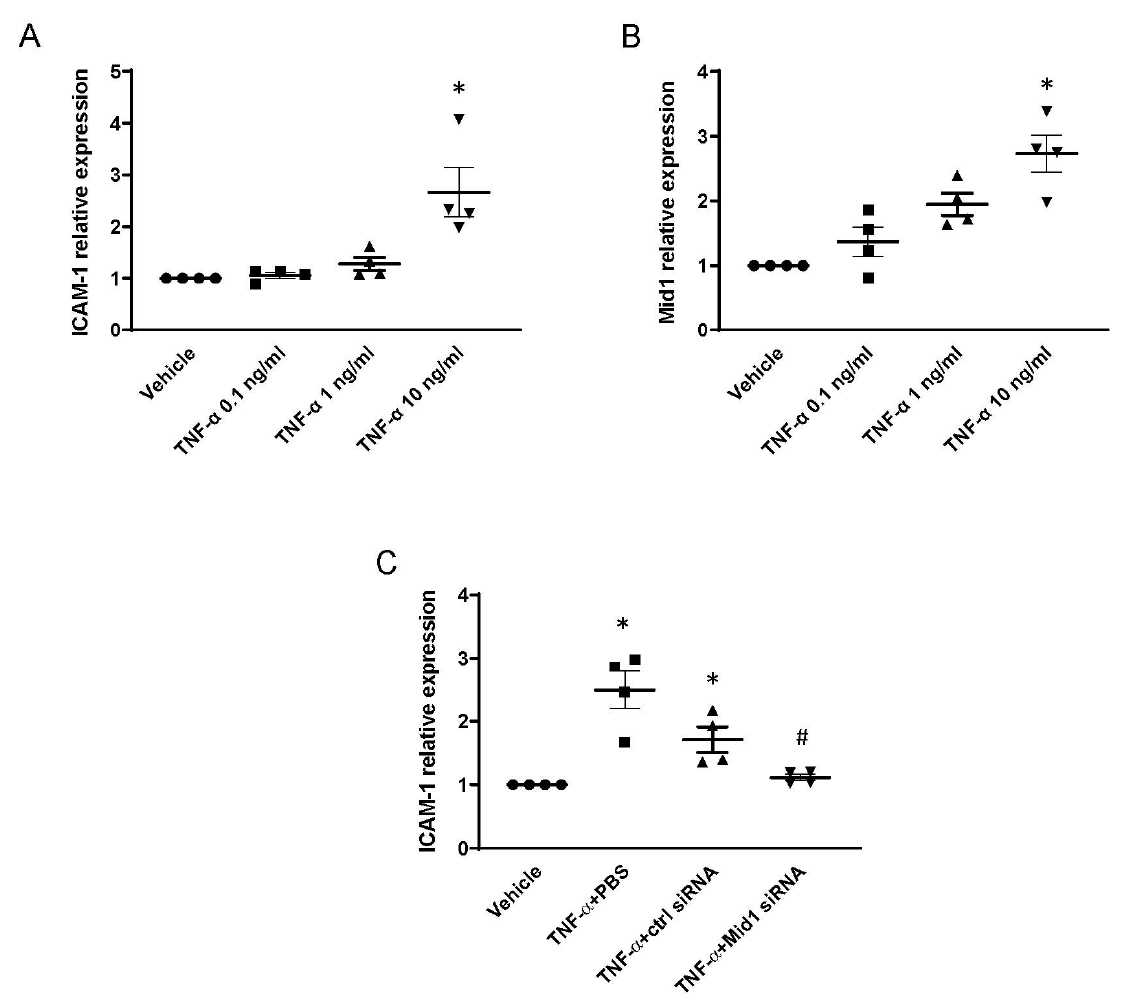
Figure 6. TNF- α increased ICAM-1 expression in primary HLMVEC and silencing of Mid1 by siRNA reduced the expression of ICAM-1 in vitro. HLMVEC were treated with vehicle and TNF- α (0.1–10 ng/mL) for 1 h and then expression of ( A ) ICAM-1 and ( B ) Mid1 mRNA was determined by RT-qPCR. ( C ) HLMVEC were transfected with 100 nM negative control siRNA and Mid1 siRNA for 24 h followed by stimulation with 10 ng/mL human TNF- α . ICAM-1 mRNA expression was determined by RT-qPCR 1 h after TNF- α stimulation. Data are mean ± SEM and n = 4. * p < 0.05 vs. Vehicle, # p < 0.05 vs. TNF- α + Control siRNA.